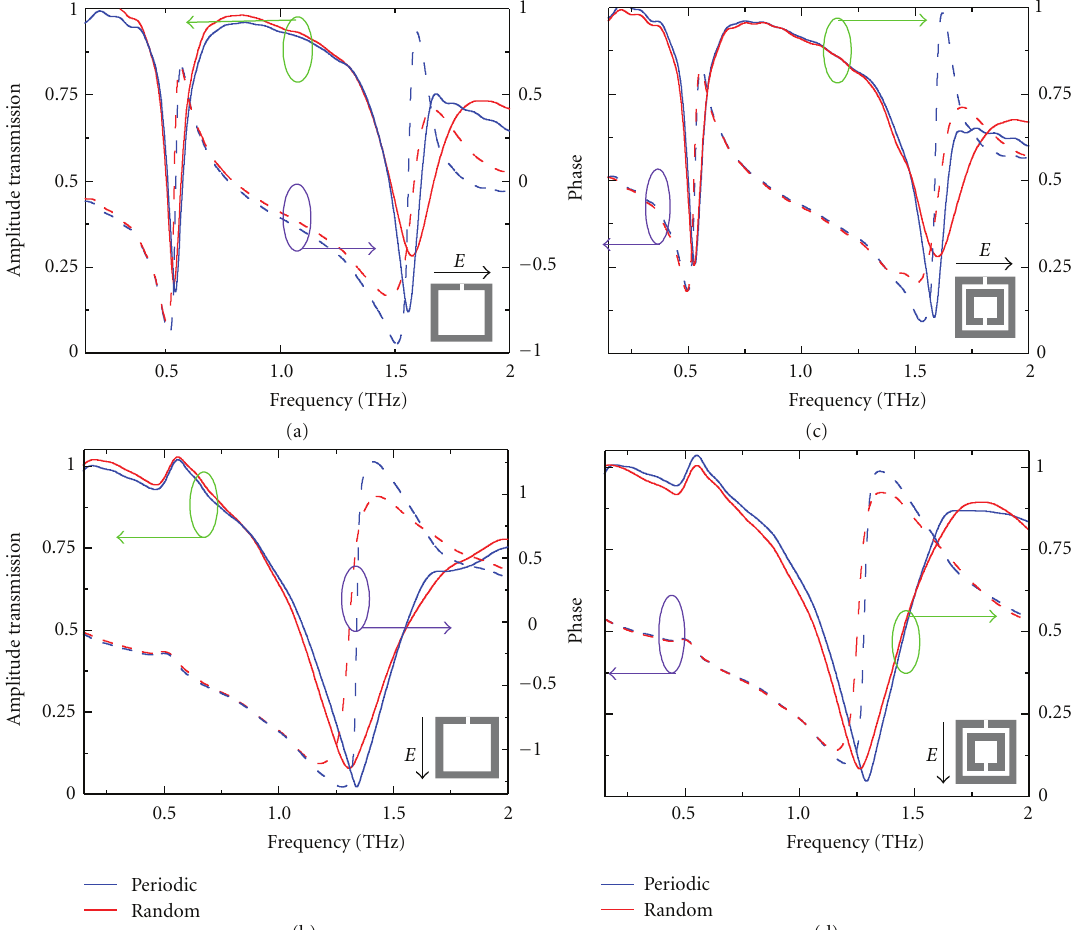
Figure 9: Measured (a) parallel and (b) perpendicular excitation of single-ring periodic and random resonators; (c), (d) are the same for double-ring resonators. The dash curves are the corresponding phase